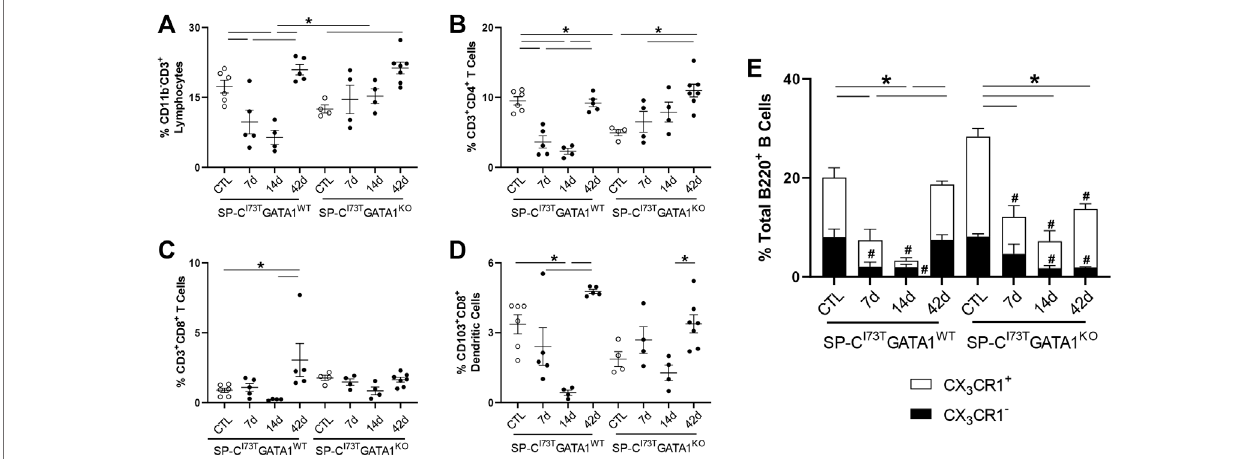
FIGURE 6 | Effects of genetic eosinophil lineage ablation on lymphoid in fl ammatory cell dynamics following SP-C I73T induced injury. (A – D) Flow cytometric quanti fi cation of (A) CD11b − CD3 + neutrophils, (B) CD3 + CD4 + Tcells, (C) CD3 + CD8 + Tcells,and (D) CD103 + CD8 + dendriticcellsfrom collagenasedigestedlungs from oil treated controls (Ctl), or tamoxifen treated SP-C I73T GATA1 WT and SP-C I73T GATA1 KO mice at 7 days, 14 days, or 42 days post injury. A p < 0.05 (*) was considered signi fi cant. Lines mark signi fi cant groups. (E) Relative abundance of total of B220 + B-cells in SP-C I73T GATA1 WT and SP-C I73T GATA1 KO mice. Data are presented as mean ±SEM( n =4 – 6mice/group), analyzed using two-way ANOVA. A p < 0.05 wasconsidered signi fi cant. Note thateach column comprises CX 3 CR1 − (black); and